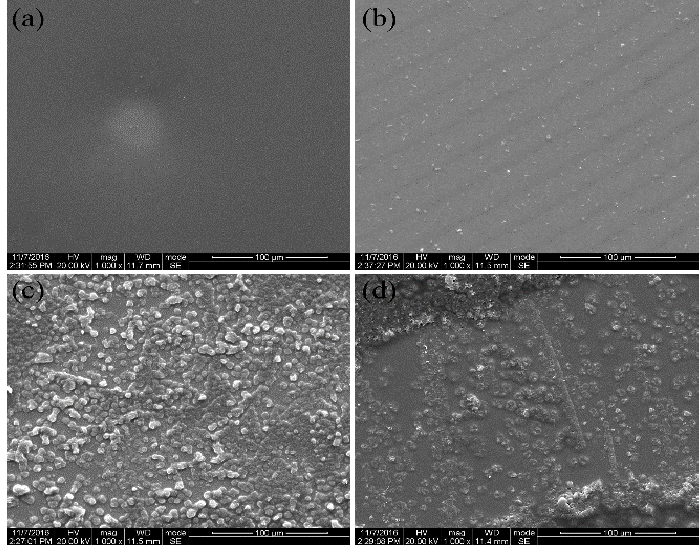
Figure 7. SEM of the process of growth of the PEN ‐ Ph crystals at 280 °C. ( a ) 0 min; ( b ) 10 min; ( c ) 30 min; ( d ) 60 min.